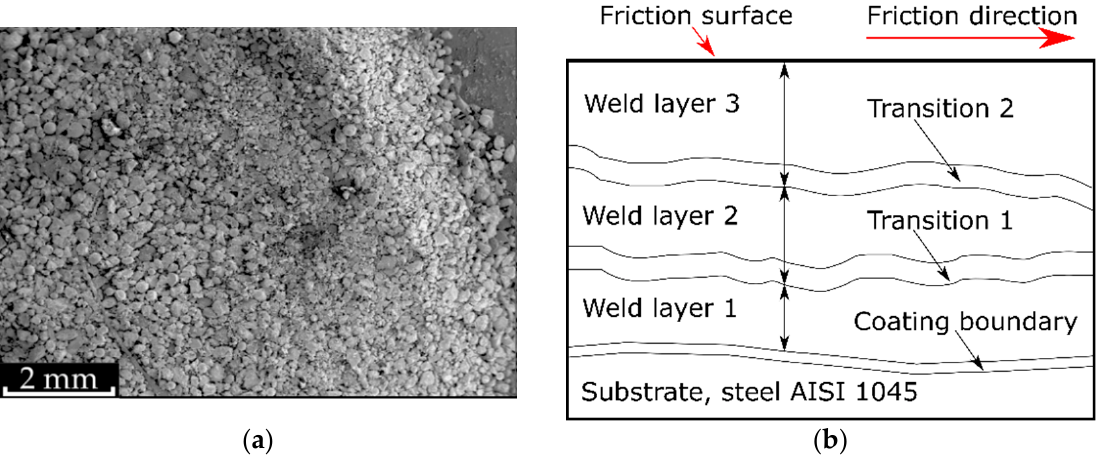
Figure 1. The structure of the studied sample: ( a ) the morphology of the filling powder mixture, and ( b ) the layout of the coating deposited be MIG-welding in three weld passes.